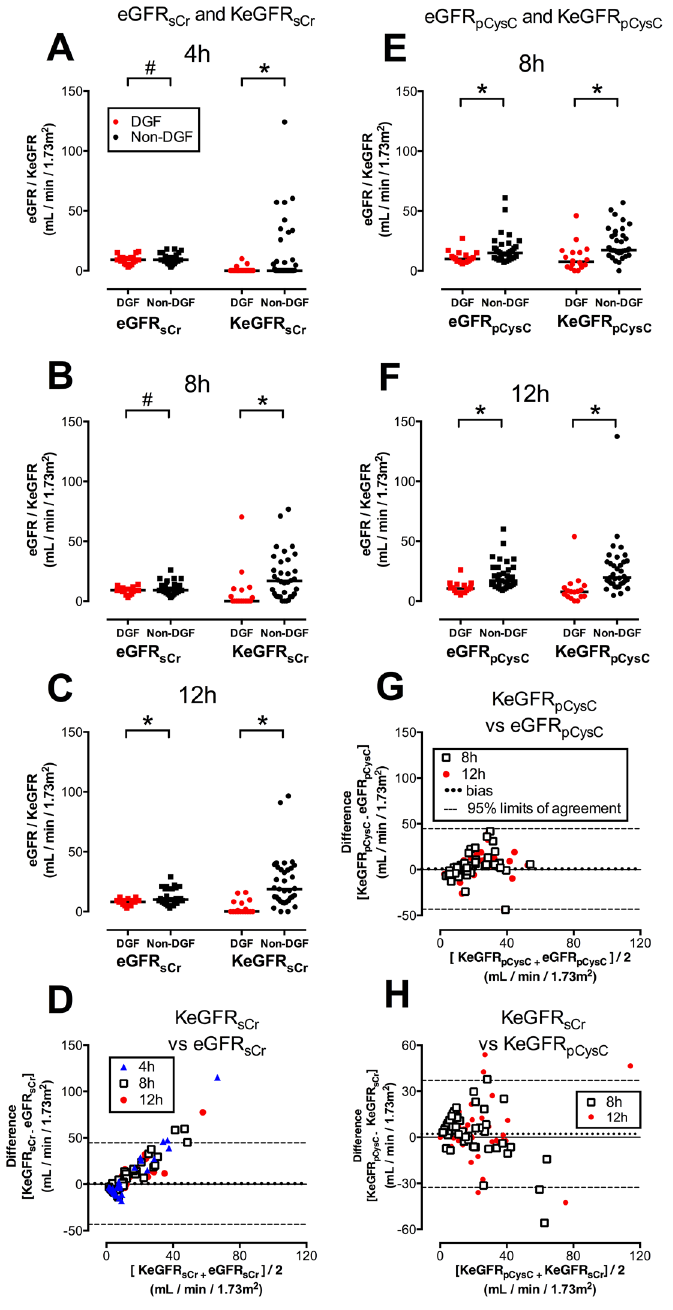
Fig 3. KeGFR prediction of DGF compared with unadjusted eGFR and sCr. A: estimated kinetic GFR using serum creatinine (KeGFR sCr ) compared with serum creatinine (sCr) and unadjusted estimate of GFR using sCr (eGFR sCr ). Figures show area under receiver operator characteristic curve (AUC) and 95% confidence intervals for prediction of DGF at 4h (n = 56), 8h (n = 52) and 12h (n = 52). Asterisk ( * ) denotes p < 0.05 for the comparison with the AUC for sCr at the same